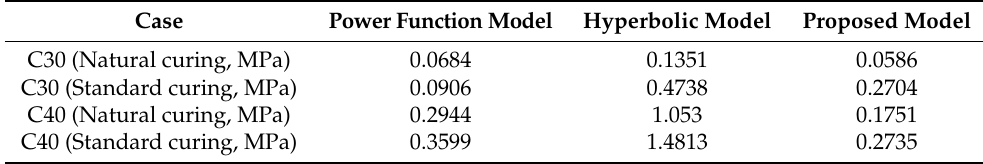
Table 1. The total fitting errors of the three prediction models.